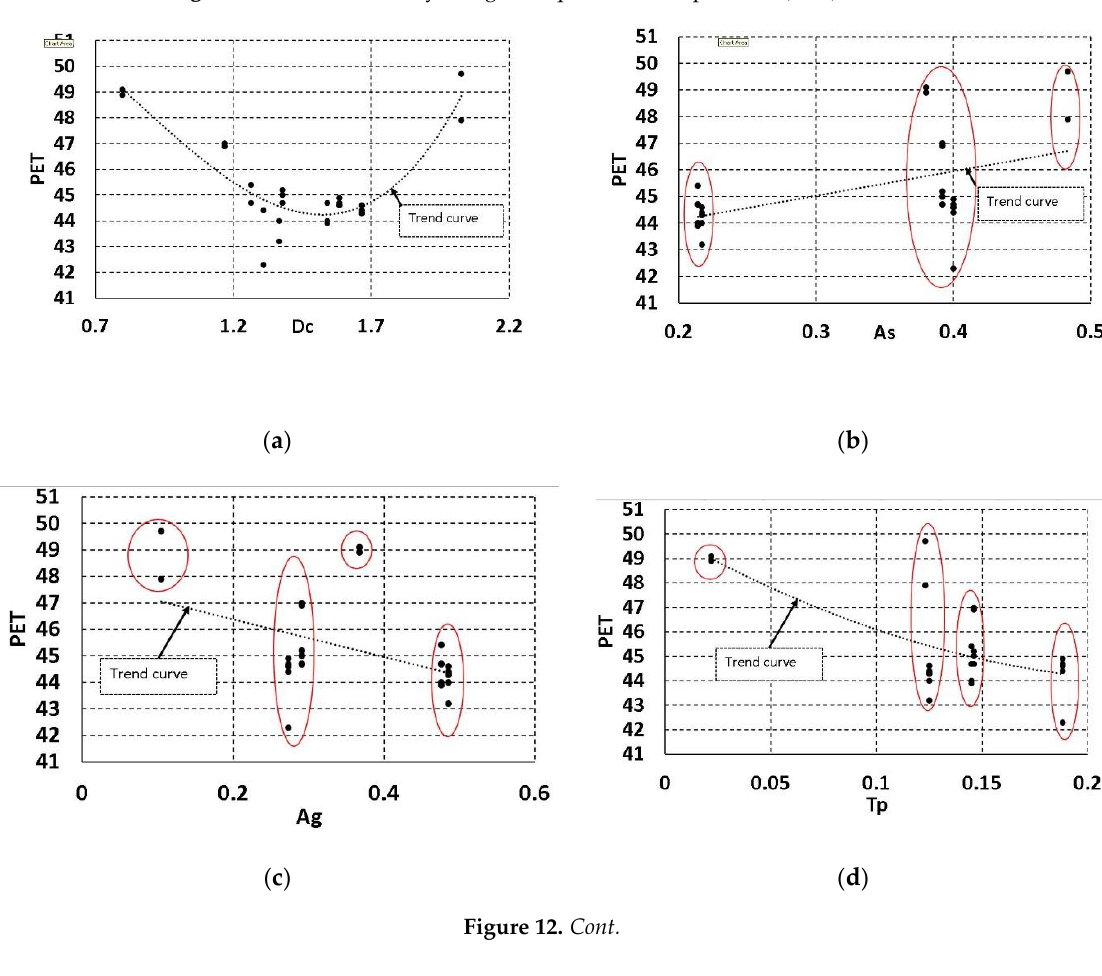
Figure 11. Variation of Physiological Equivalent Temperature (PET) values.